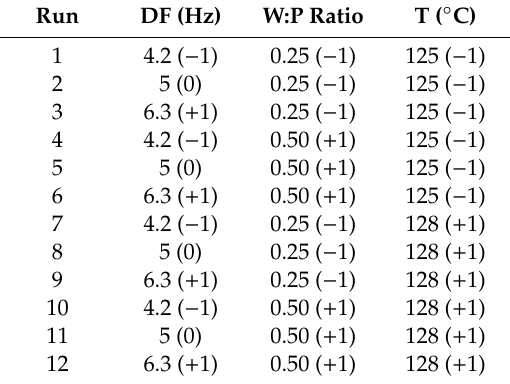
Table 1. Experimental design in standard order. Coded levels of experimental factors appear in parentheses. DF = drum frequency; W:P = water-to-pulp ratio; T = drum surface